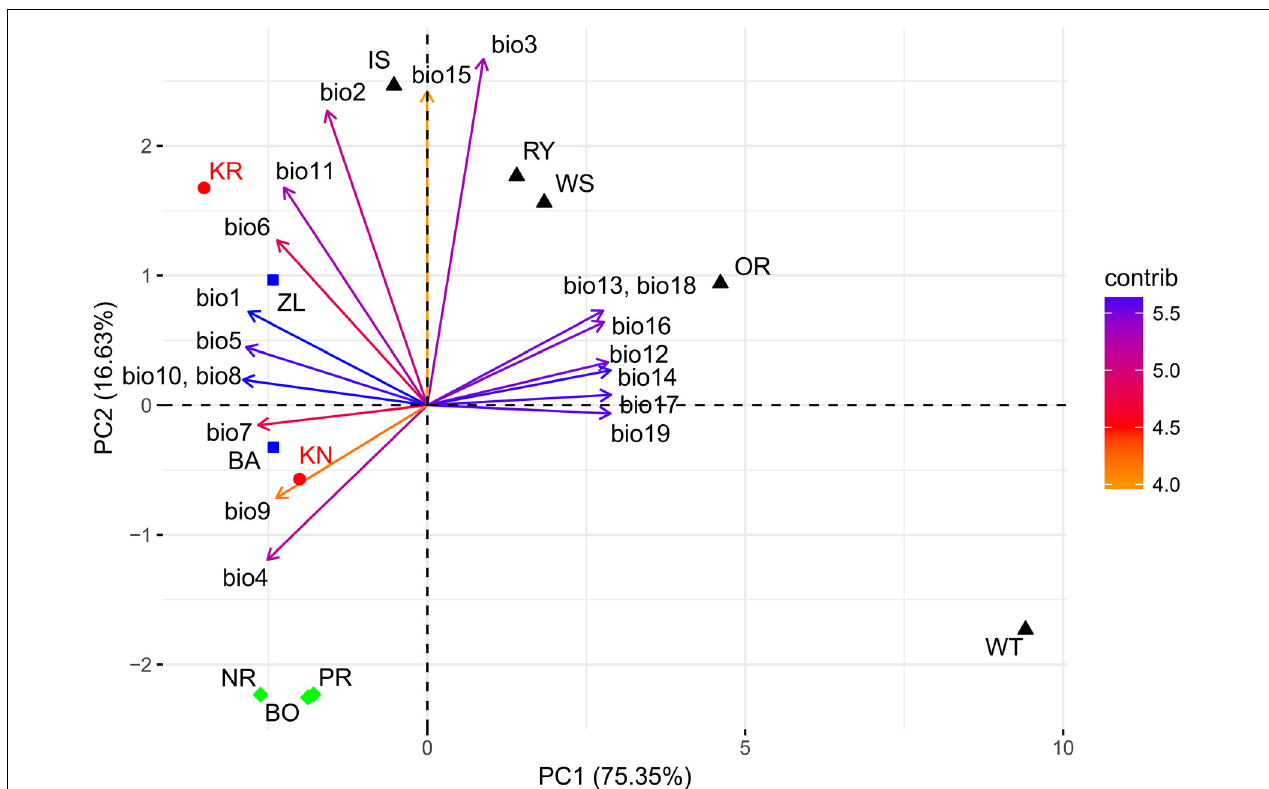
FIGURE 9 | Climate-related variability between provenances and experimental sites based on bioclimatic indexes. Explanations: KR, KN – Kórnik and Knyszyn testing site; BO, PR, NR – northern provenance group, BA, ZL – eastern provenance group, IS, WS, RY, OR, WT – southern provenance group. Variables vector color according to their contribution in total variance: orange – low, blue –